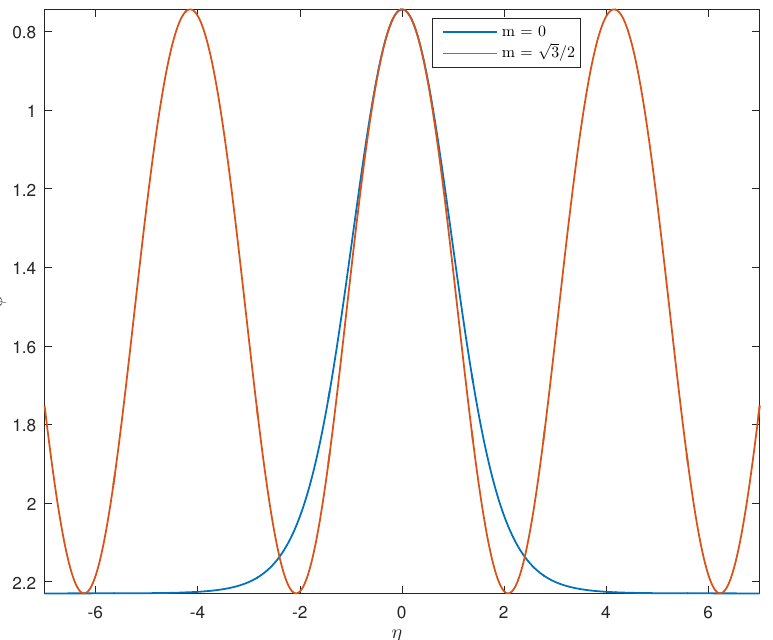
Figure 15. The graphical representation of quasi-soliton for MKdV equation for which its analytical form is represented by Equation (54).